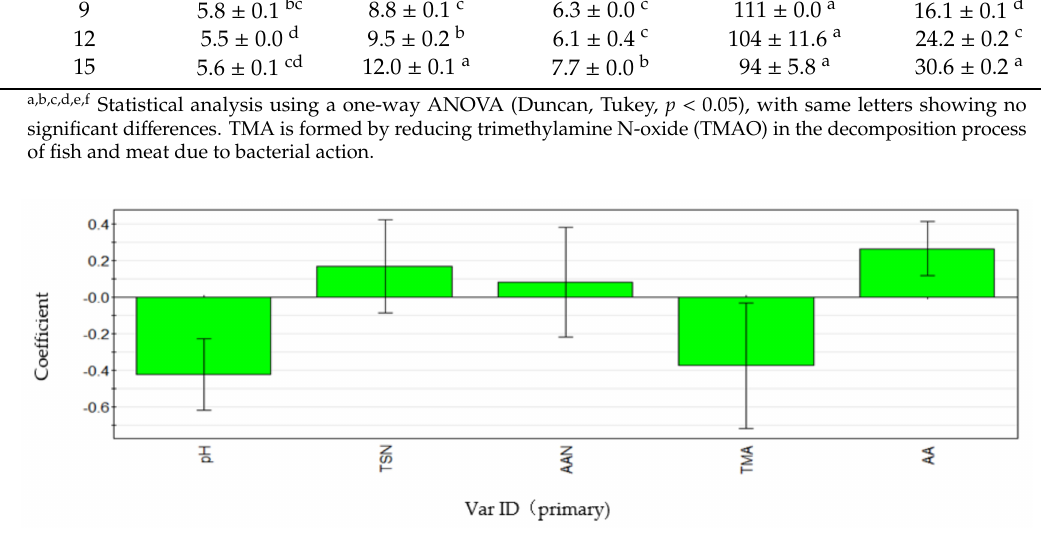
Figure 2. Regression coe ffi cient of fermentation time and physical and chemical index. TMA is formed by reducing trimethylamine N-oxide (TMAO) in the decomposition process of fish and meat due to bacterial